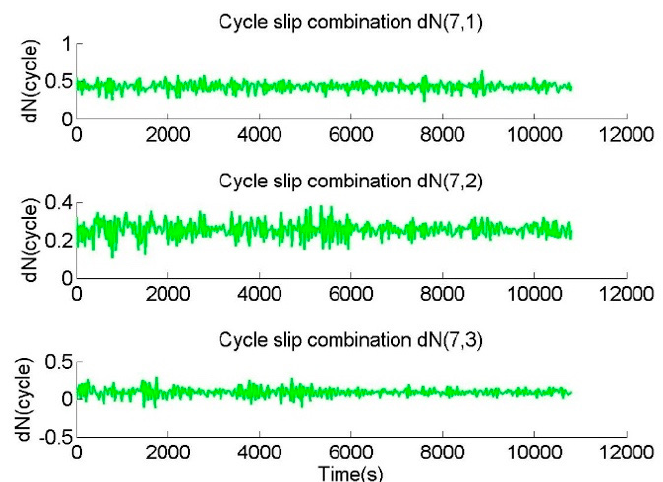
Figure 7. Cycle slip combinations of GTCSR, where the epoch–difference pseudoranges have been appended with gross errors of 2.5 m epoch by epoch and the phases are without cycle slips on GPS satellite 10 at CUT0 station during the geomagnetic storm that started from UTC 2016/05/08 00:00:00.